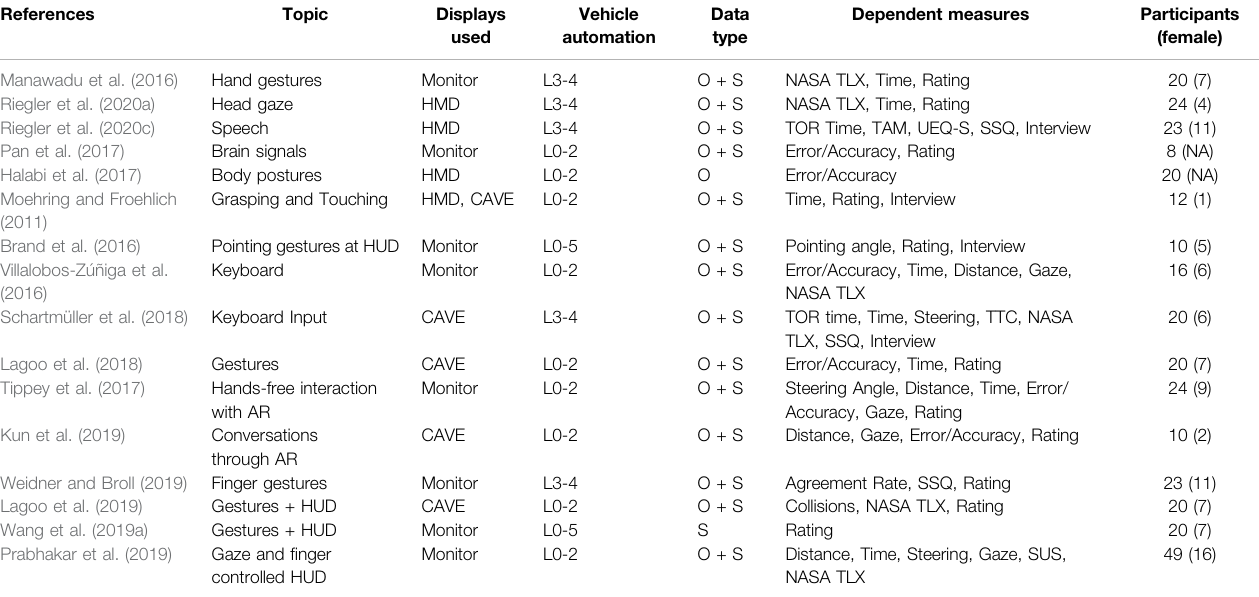
TABLE 10 | Summary of user studies in Interaction Modalities application